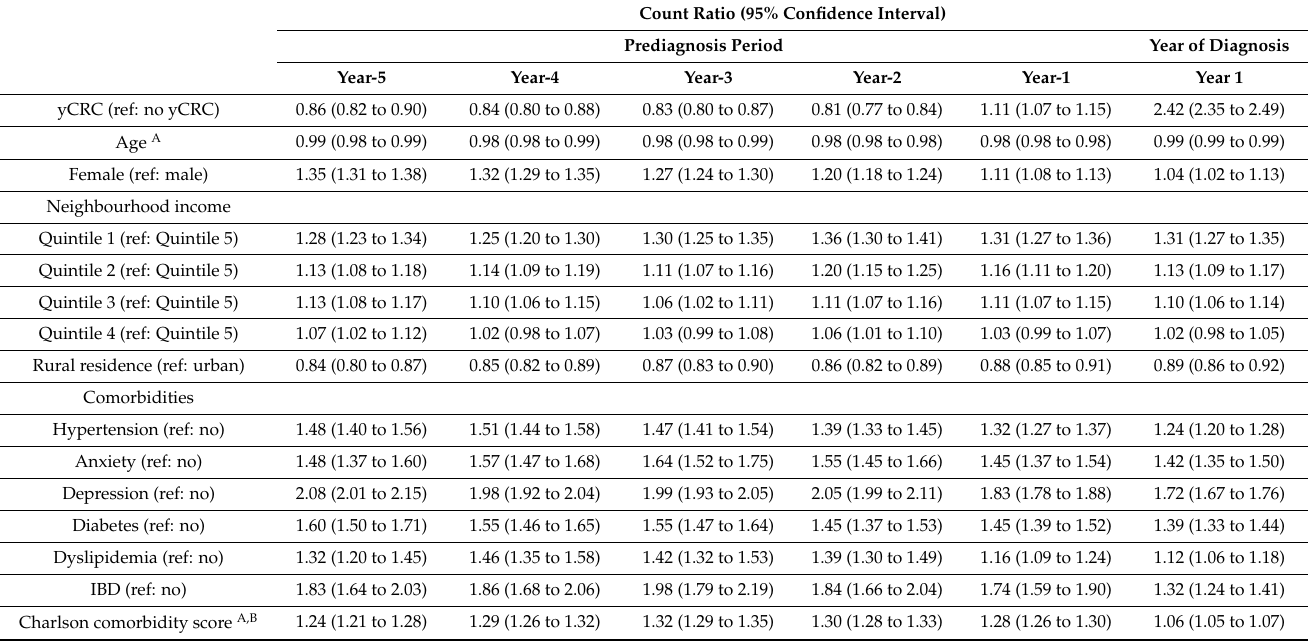
Table 3. Multivariable Poisson regression models showing association between diagnosis of yCRC and outpatient visits during prediagnosis period (years-5 to -1) and year of diagnosis (year